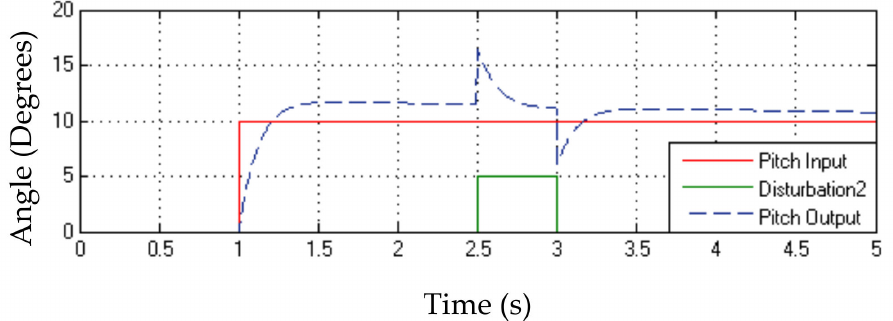
Figure 12. PID response to a step of 10 ◦ with a disturbance of 5 ◦ .